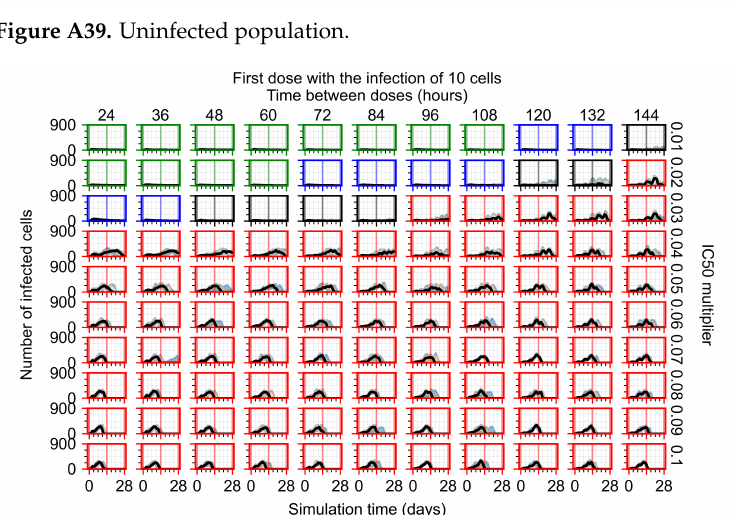
Figure A40. Infected (eclipse phase)